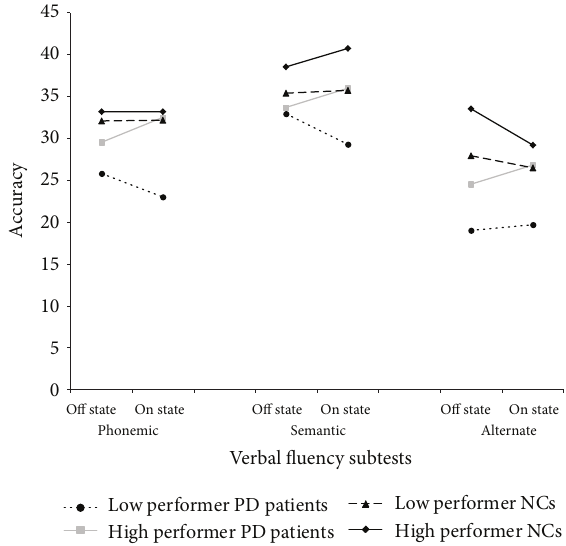
Figure 2: Average performance on fluency subtests of individuals in the four experimental groups on fluency